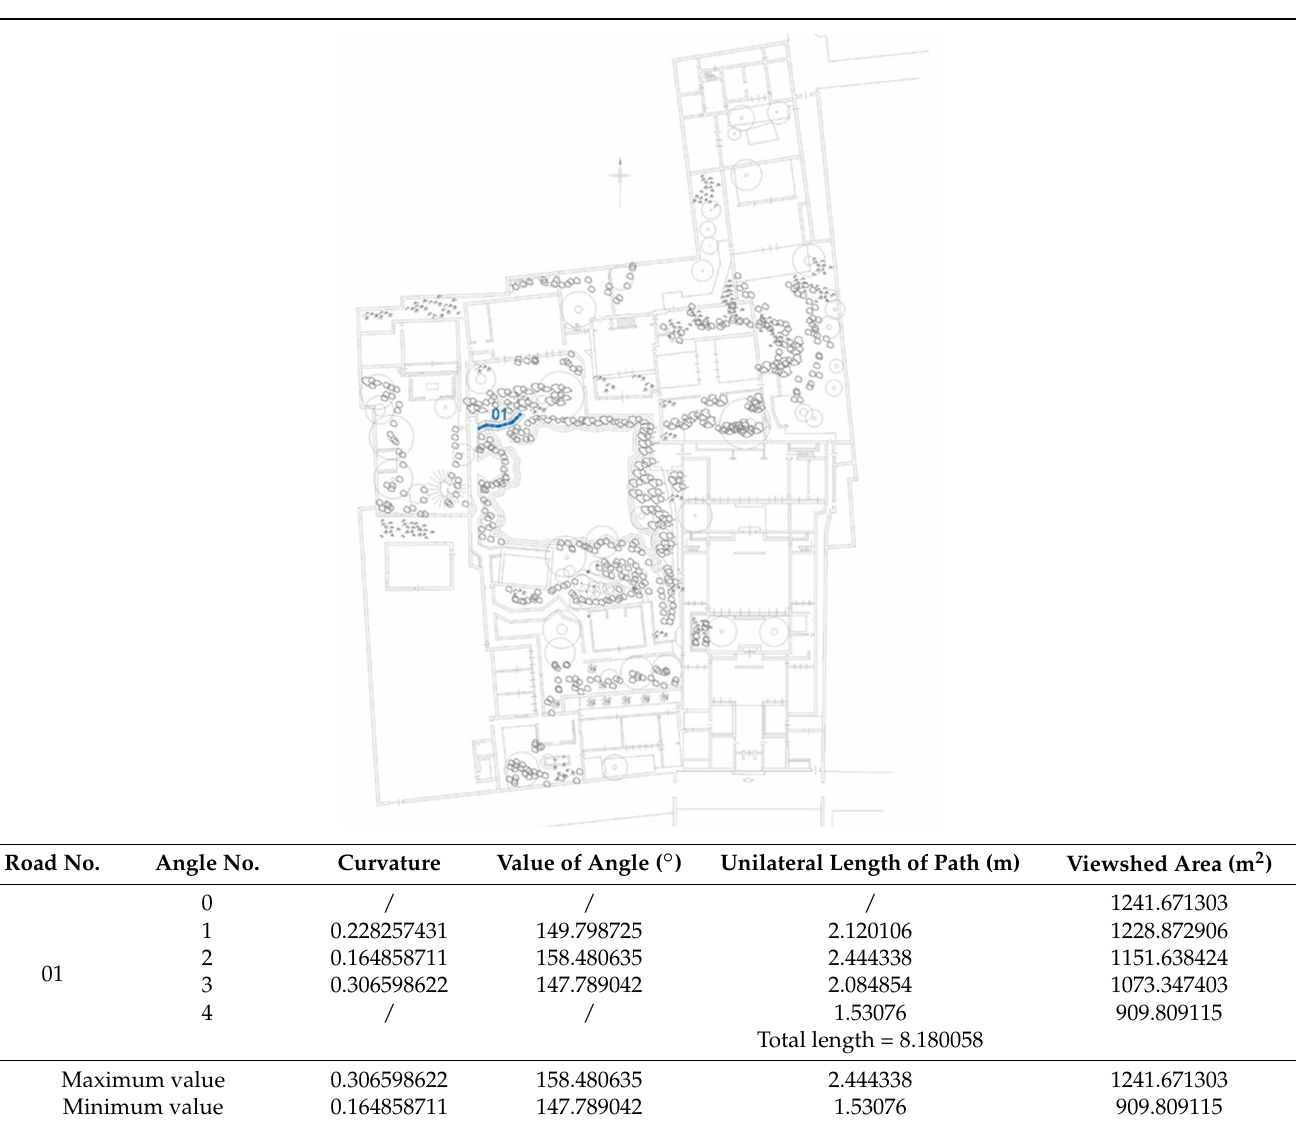
Table A23. Master of the Nets Garden, bridge.